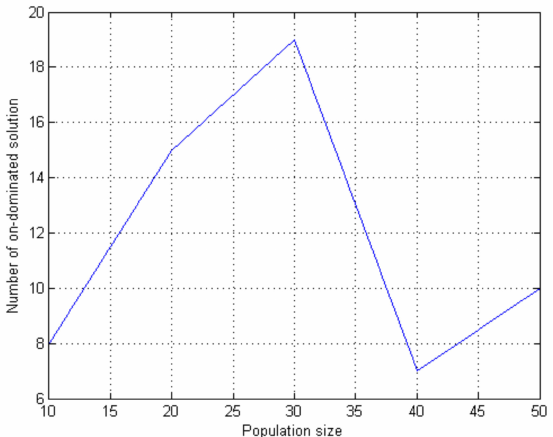
Figure 6. Number of nondominated solutions vs. population size.